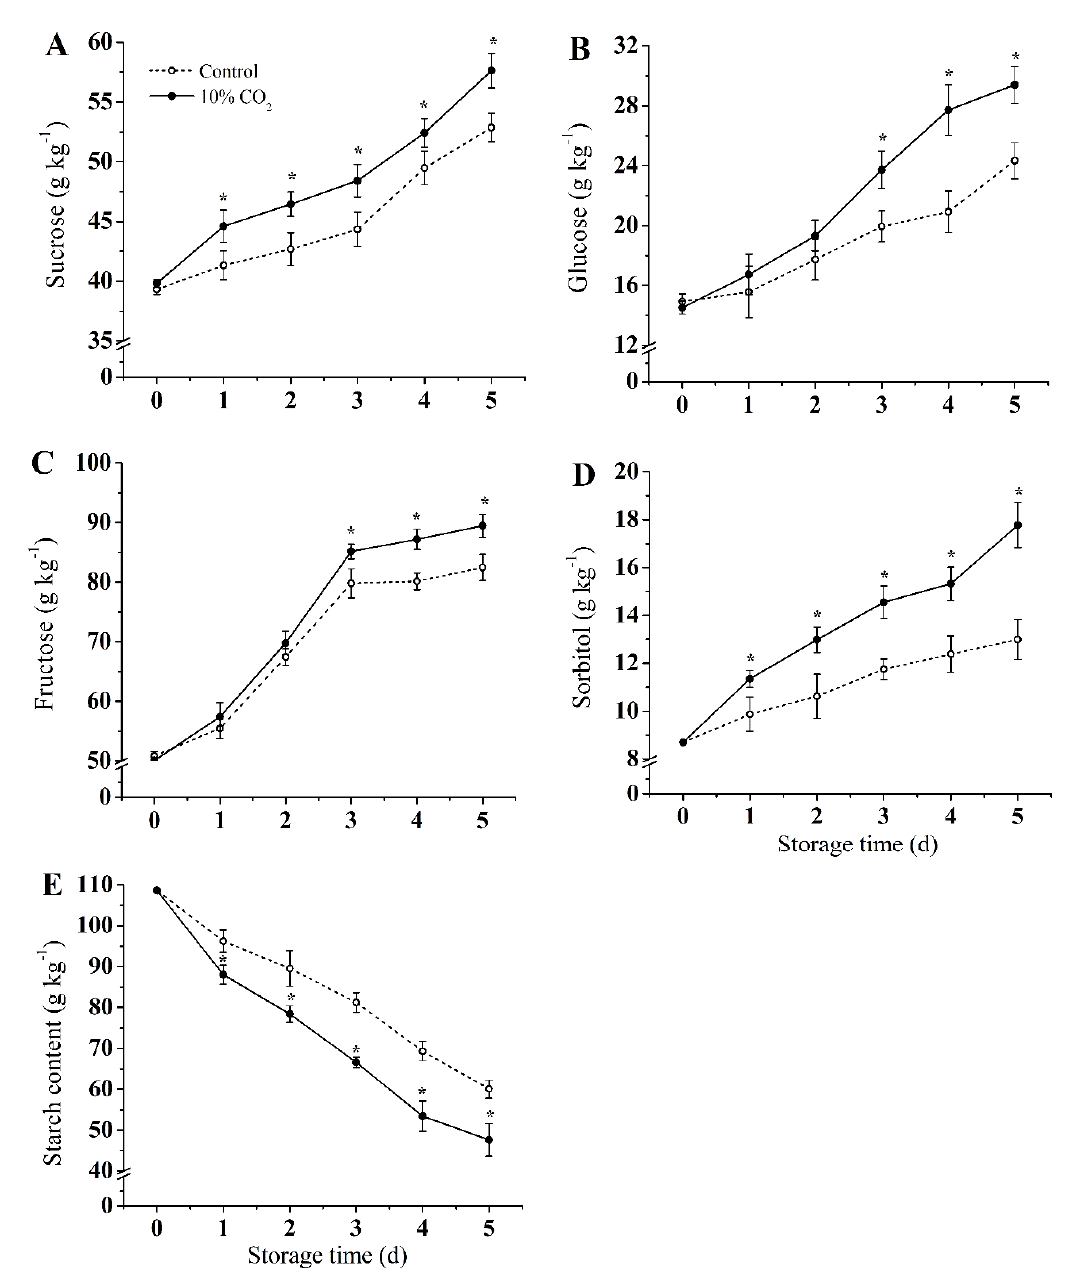
Figure 2. Effect of CO 2 on sucrose ( A ), glucose ( B ), fructose ( C ), sorbitol ( D ), and starch ( E ) content of fresh-cut pear fruit during storage. Values are presented as means ± SD ( n = 9). Asterisks (*) indicate significant differences at the same time between controls and CO 2 -treated fruit according to the Student’s-test ( p < 0.05).